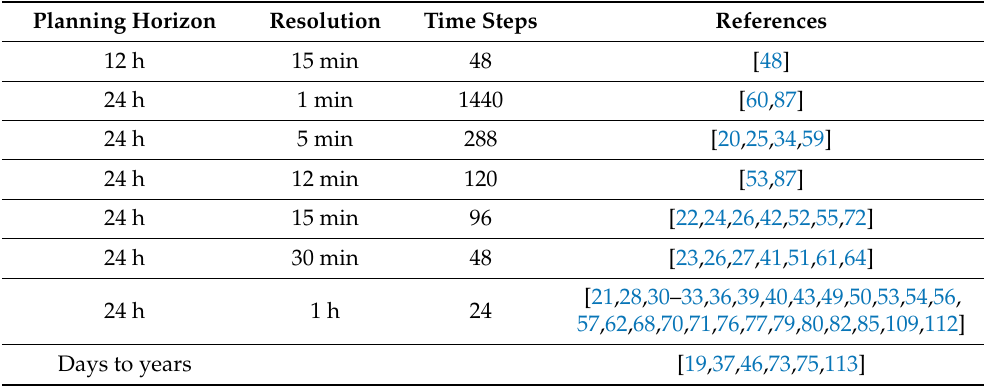
Table 17. Planning horizon, the resolution, and time steps used in the selected papers. Planning